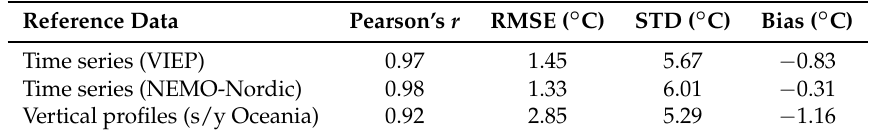
Table 3. Statistical comparison between modeled temperature and reference data from in situ measurements (VIEP and s/y Oceania) and numerical data (NEMO-Nordic).